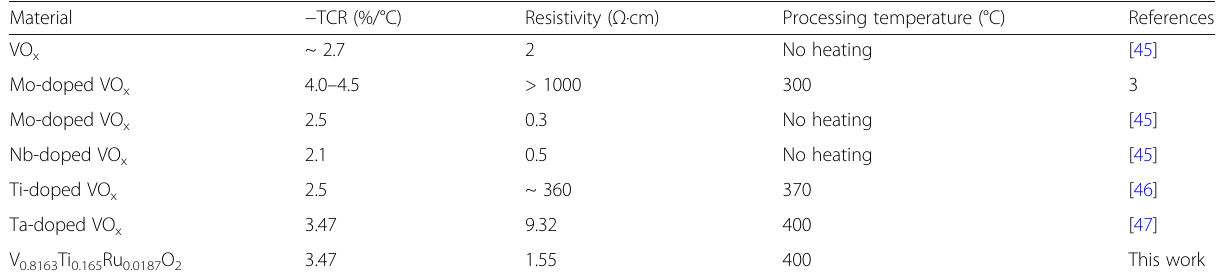
Table 2 TCR, RT resistivity, and processing temperature of V 0.8163 Ti 0.165 Ru 0.0187 O 2 and other vanadium oxide-based thermal-sensitive thin films previously reported